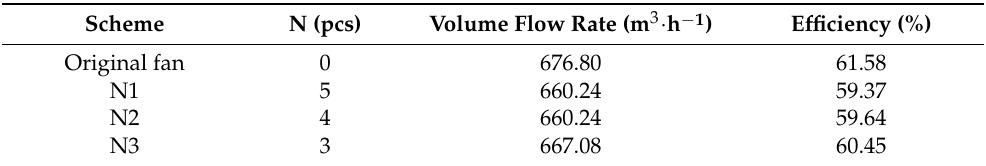
Table 2. Results of Aerodynamic Performance Varied with the groove number N.